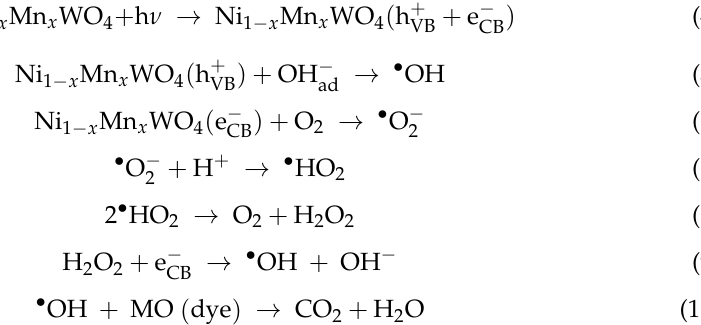
Figure 10 represents the mechanism of photodegradation of MO by Ni 1 − x Mn x WO 4 NC under visible light source. The irradiation of the photocatalyst initiates the promo- tion of electrons (e − ) from the valence band (VB) to conduction band (CB) through the photoabsorption process, leaving lots of vacancies in VB, referred to as holes (h + ),